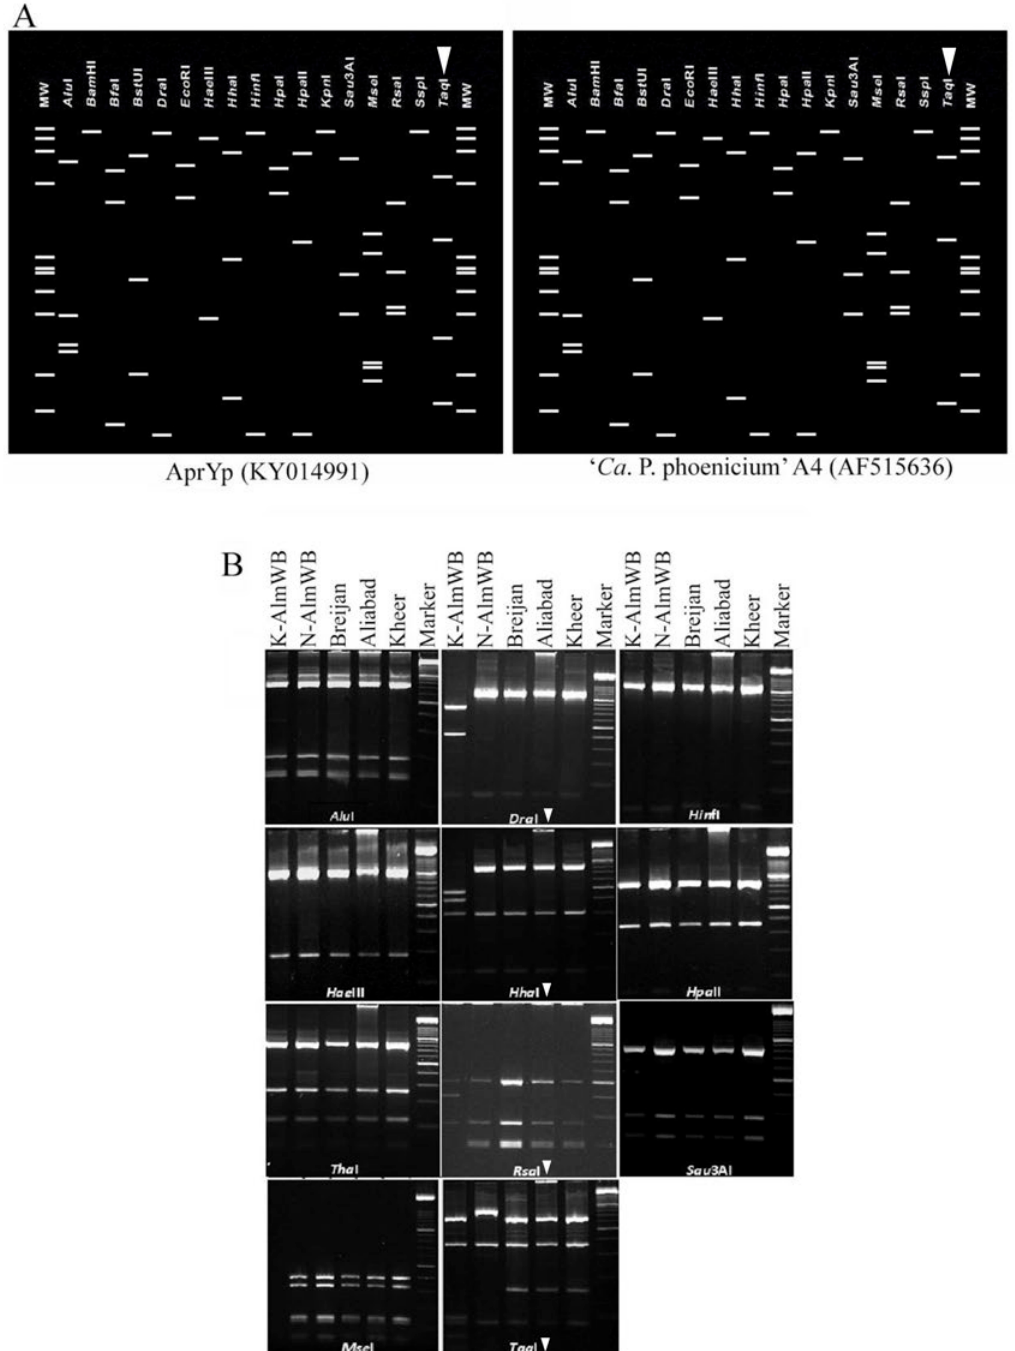
Figure 2. In silico and RFLP profiles. A, in silico RFLP profiles of Breijan AprY phytoplasma and ‘ Ca . P. phoenicium’ refer- ence strain A4 (16SrIX-B), generated with i PhyClassifier; B, RFLP profiles derived from enzymatic digestions of R16F2n/ R2 fragments amplified from AprY phytoplasma strains Breijan (clone 12), Aliabad (clone 2) and Kheer (clone 24), and strains N (Neyriz)-AlmWB (subgroup rIX-B) and K (Khafr)-AlmWB (subgroup rIX-C). Restriction fragments were electro - phoresed in 2% agarose gel. Distinguishing enzymes are marked with white